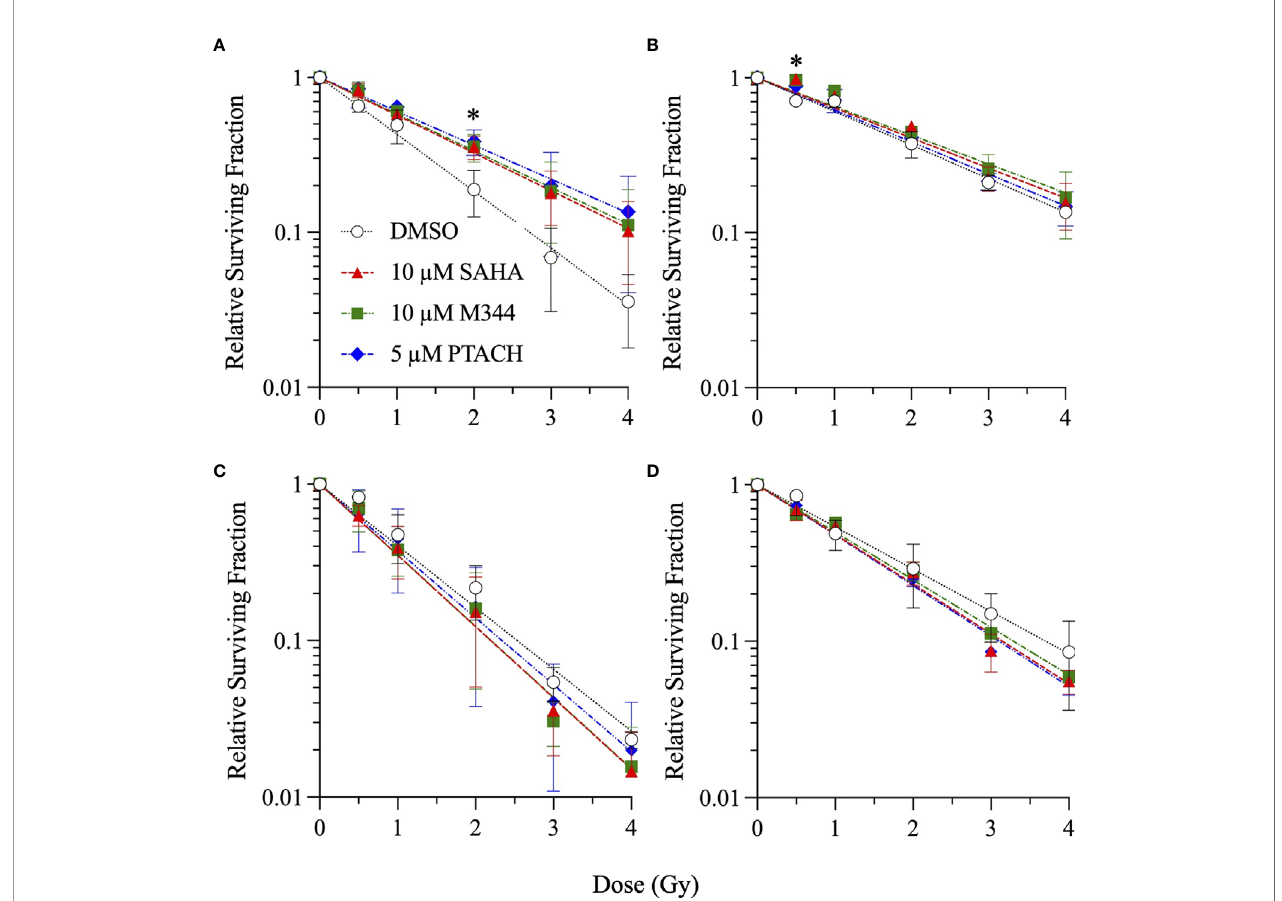
FIGURE 4 | Clonogenic survival of G0/G1-phase normal NFF28 primary fi broblasts (A) and asynchronously growing A549 lung carcinoma (B) , U2OS osteosarcoma (C) , and U87MG malignant glioma cells (D) pretreated for 18 h with 10 µM SAHA, 10 µM M344, or 5 µM PTACH and exposed to 0.5 – 4 Gy 350 MeV/n O-16 ions in the Bragg plateau region (LET = 20.90 keV/µm). Data reported as mean ± SD; where error bars are not visible, they are smaller than the data point. Asterisks mark signi fi cant differences compared to DMSO controls at p -values of ≤ 0.05 (*) by one-way